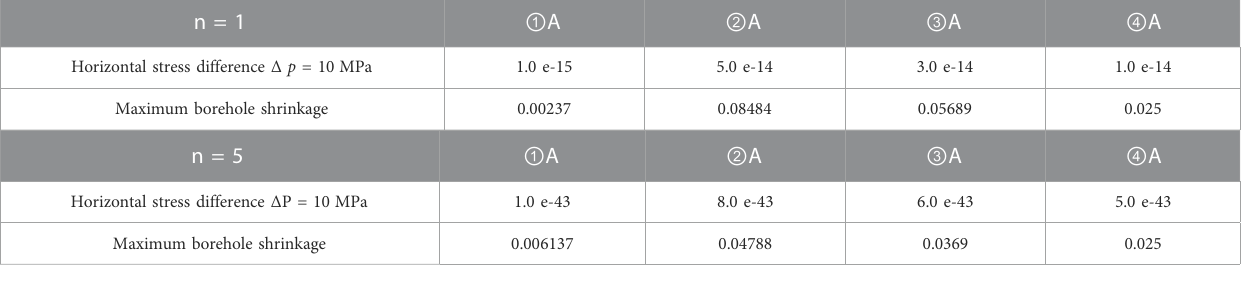
TABLE 7 The pre-coef fi cient A and the exponent n (Layer No. 3), in the case of n = 1 and n=5. n = 1